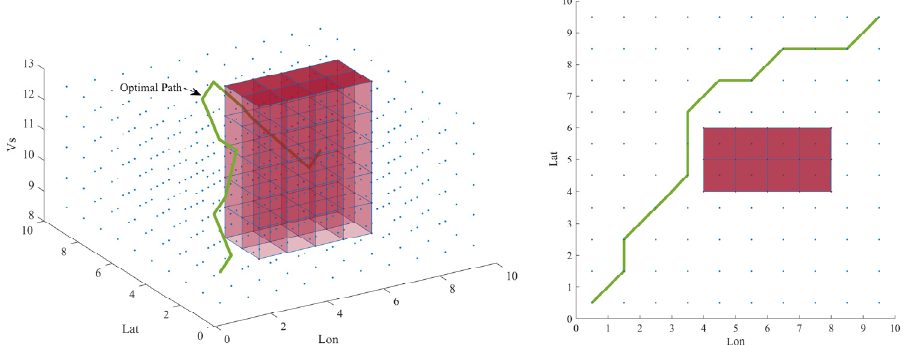
Figure 13. Illustration of optimal path searching result in 3D ( left ) and 2D projection ( right ).